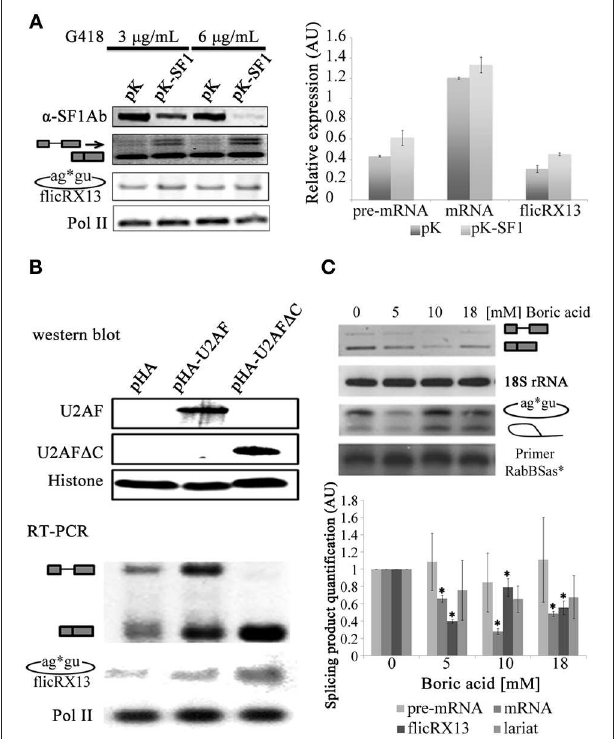
FIGURE 4 | Inhibition of the second step of splicing alters flicRNA production. (A) Stable SF1-silencing (pK-SF1) and empty pKT3M vector (pK) transfectants were established at 3 and 6 µ g/mL G418. Silencing was assessed by western blot (top) achieving 40–90% efficiency. Absence of SF1 slightly increased pre-mRNA/unspliced and mRNA Rabx13 transcripts (middle), and flicRX13 production (bottom); however, such increments were not statistically significant (right plot). (B) Amoeba transformants overexpressing wt (HA-U2AF) and carboxy-terminal deleted (HA-U2AF 1 C) U2 auxiliary splicing factor were established. Appropriate expression of the hemagglutinin-U2AF fusion proteins were monitored and compared to histone H3 expression by western blot (top). Compared to the empty Entamoeba HA expression plasmid (pHA) pHA-U2AF increased the overall expression of all RabX13 transcription products. However, HA-U2AF 1 C substantially increased mRNA (spliced) products and flicRX13. RNA polymerase II expression was equivalent between the transformants. (C) Expression of the RabX13 gene transcript variants (unspliced, spliced, flicRX13 and intron lariat) after incubation of E. histolytica trophozoites with different concentrations of boric acid, an inhibitor of the second step of splicing. 18S rRNA expression was used for normalization purposes. To detect intron lariats, circular RT-PCR was carried out with the 32 P-labeled Rab2BSas primer (Rab2BSas*), which was used as the loading control. Bottom panel, products in the upper panel were quantitated and statistically analyzed. Decrease of spliced RabX13 variant and flicRX13 were statistically significant (ANOVA P ≤ 0.001, asterisks in bold). Values are the average of three independent